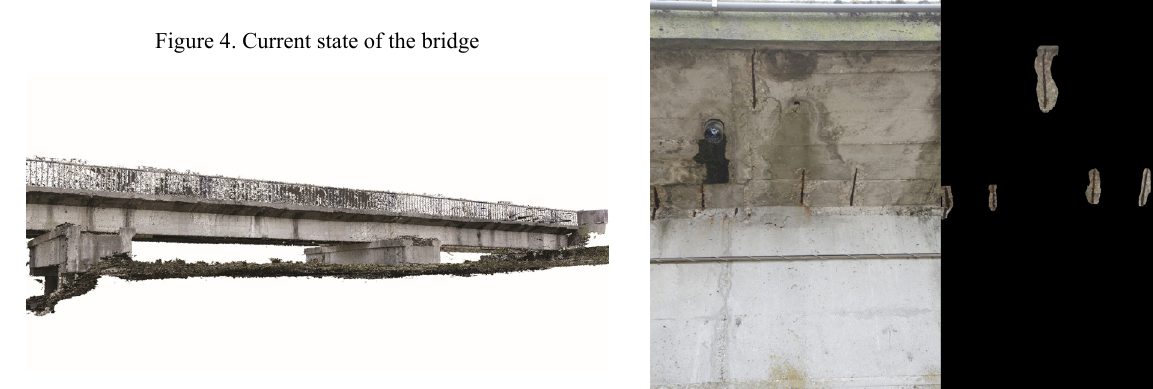
Figure 5. Photogrammetric point cloud